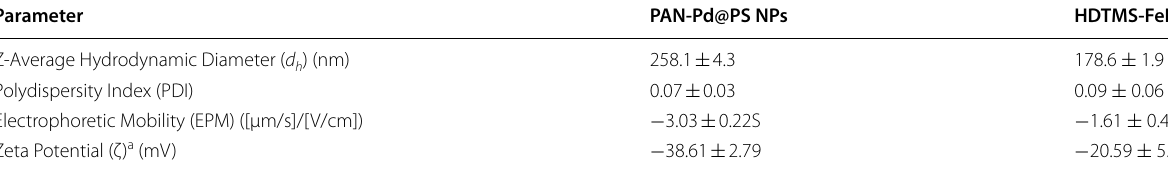
Error bars indicate a Reported by instrument using Hückel Model; value not adjusted for pH/ionic strength of